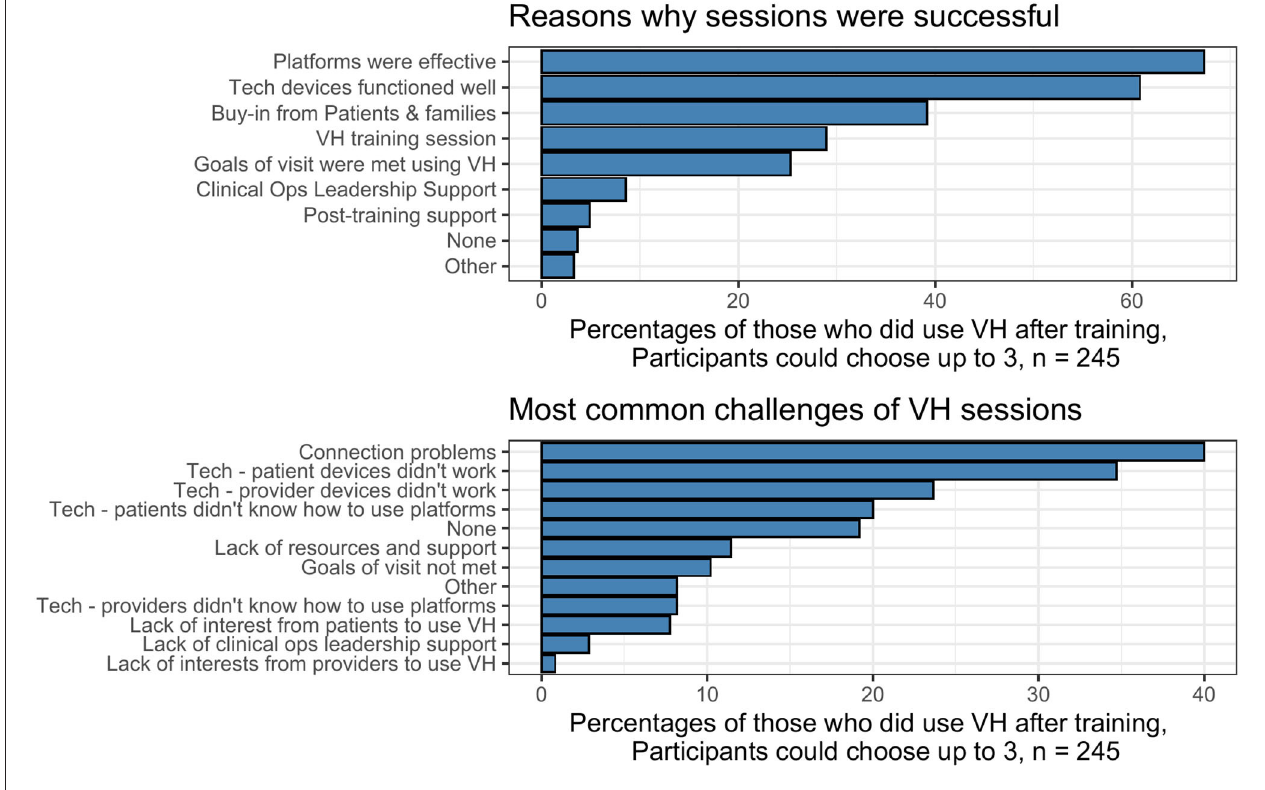
FIGURE 2 | Facilitators and barriers to the success of the VH sessions, as indicated by the participants.